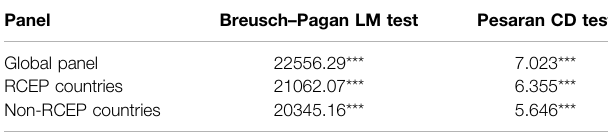
TABLE 3 | Results of the cross-sectional dependence